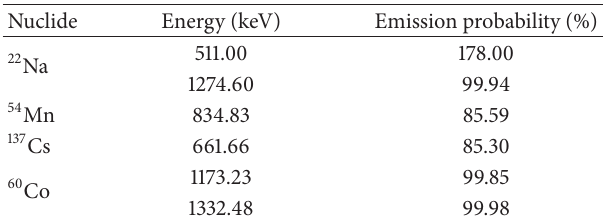
Figure 4: Detection efficiency of NaI(Tl) detector as a function of gamma ray energies (source placed at 0,5 cm distance to the detector face). Table 2: The energies and emission probabilities of the radioisotope source